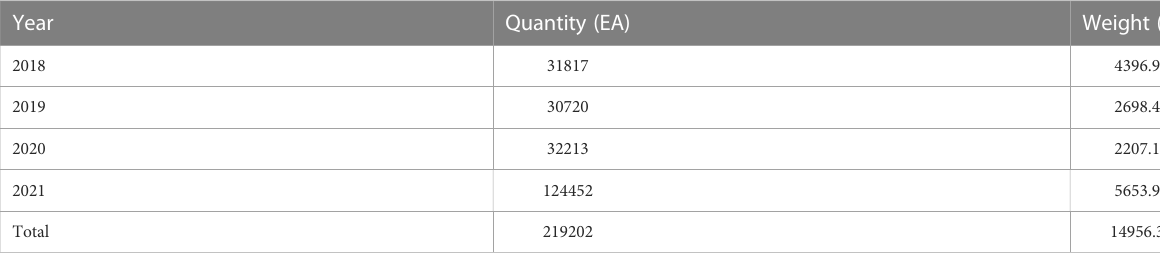
TABLE 3 South Korea monitors the amount of marine waste on its